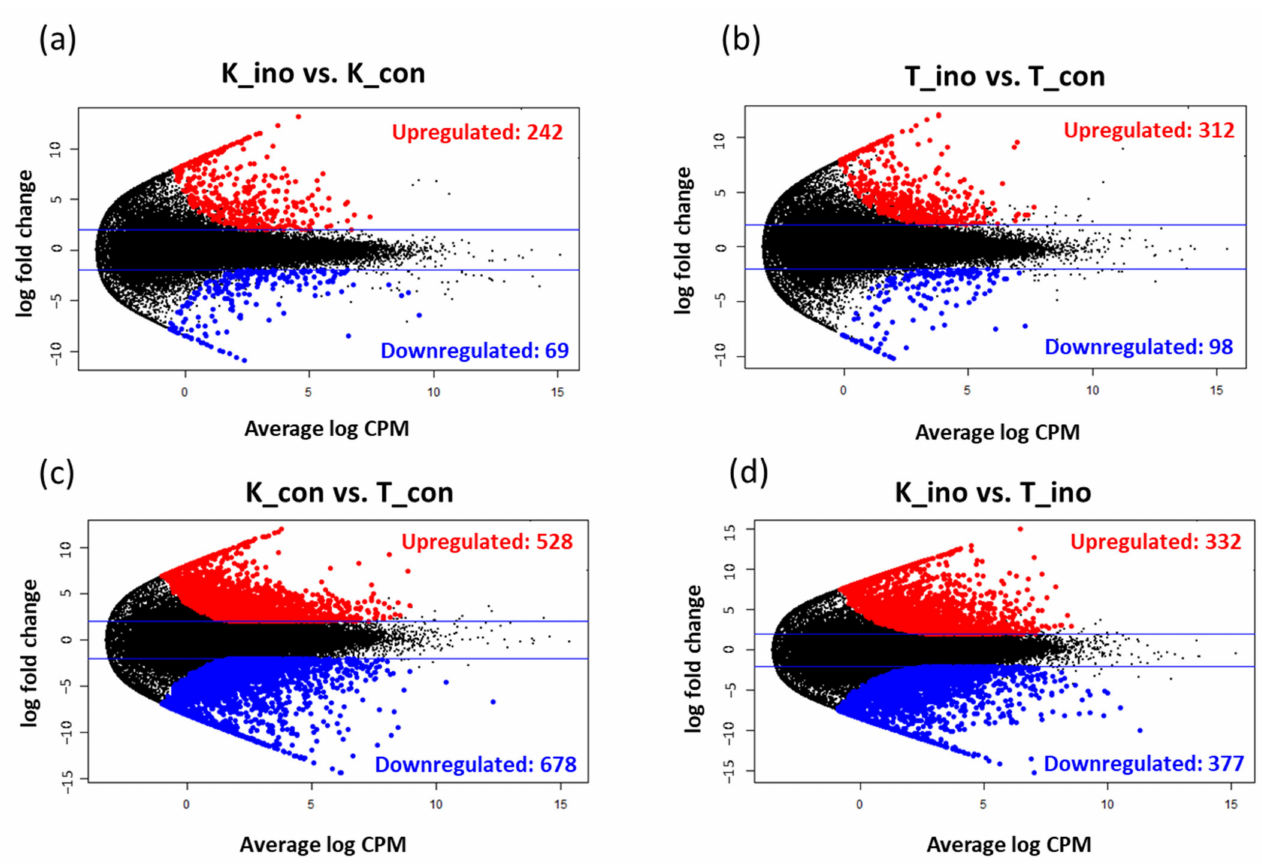
Figure 2. MA plots of the identified differentially expressed genes (DEGs). Red and blue dots represent the upregulated and downregulated DEGs, respectively. Black dots represent the non-differentially expressed genes. ( a ) DEGs between the control (K_con) and inoculation (K_ino) plots of Kyushu No. 166 (K166); ( b ) DEGs between control (T_con) and inoculation (T_ino) plots of Tamayutaka; ( c ) DEGs between the control plots of K166 and Tamayutaka; ( d ) DEGs between the inoculation plots of K166 and